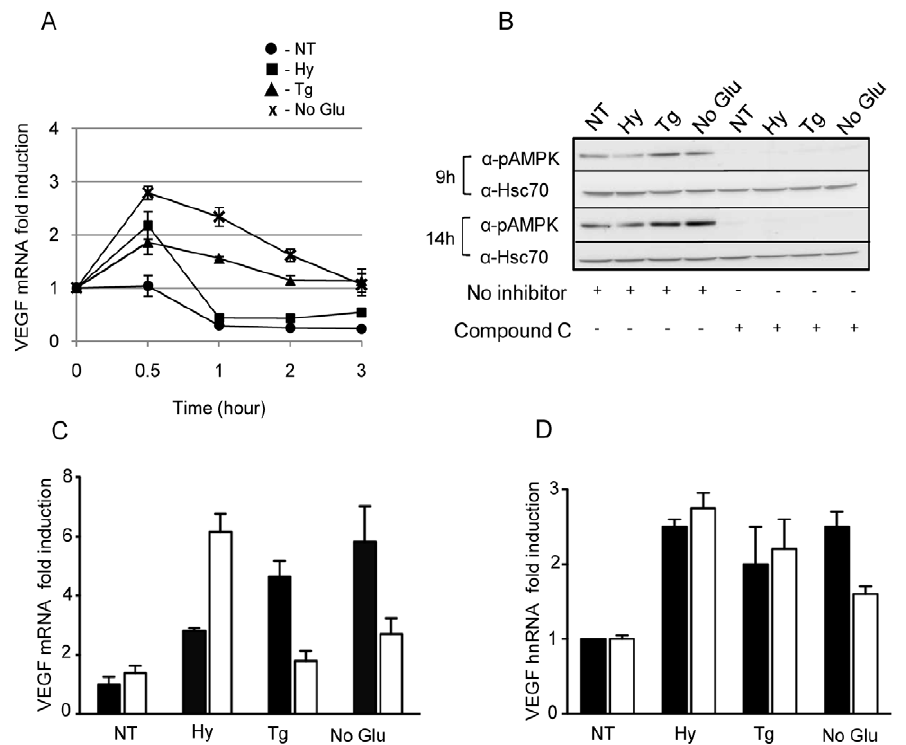
Figure 2. UPR activation stabilizes VEGF mRNA via AMPK. ( A ) C6 cells were pre-treated with normal culture conditions (NT-circle), 1% O 2 (Hy- square), thapsigargin (Tg-triangle), or no glucose media (No Glu-cross) for 6 hours. Actinomycin D (5 m g/ml) was added to the various cultures to block further transcription. At the indicated times, total RNA was extracted and subjected to qRT-PCR to determine VEGF mRNA levels. The mean values of data from duplicate experiments are presented ( 6 SD). ( B ) C6 cells were either left untreated or treated as indicated in the figure in the presence or absence of Compound C for 9 hours or 14 hours. Western blot analysis was performed on cell lysates to determine levels of p-AMPK. Hsc70 was used as loading control. ( C–D ) C6 cells were pretreated with different stress inducers for 6 hours as indicated. No inhibitor (black) or compound C (AMPK inhibitor- white) was added to the cells as indicated for an additional 8 hours. Total RNA was extracted for qRT-PCR to determine VEGF mRNA ( C ) and VEGF hnRNA ( D ) levels. Experiments were performed in triplicate (values are mean 6